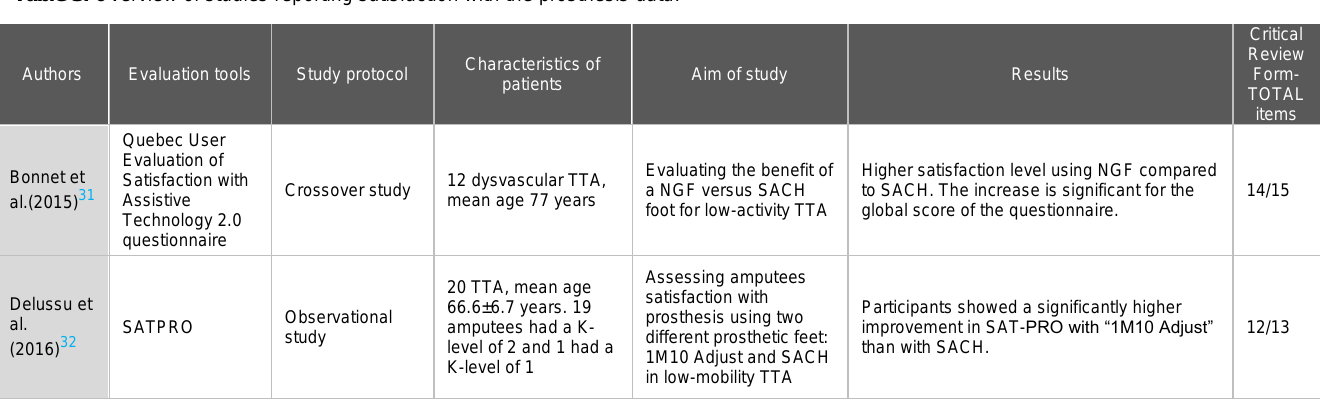
Table 3: Overview of studies reporting satisfaction with the prosthesis